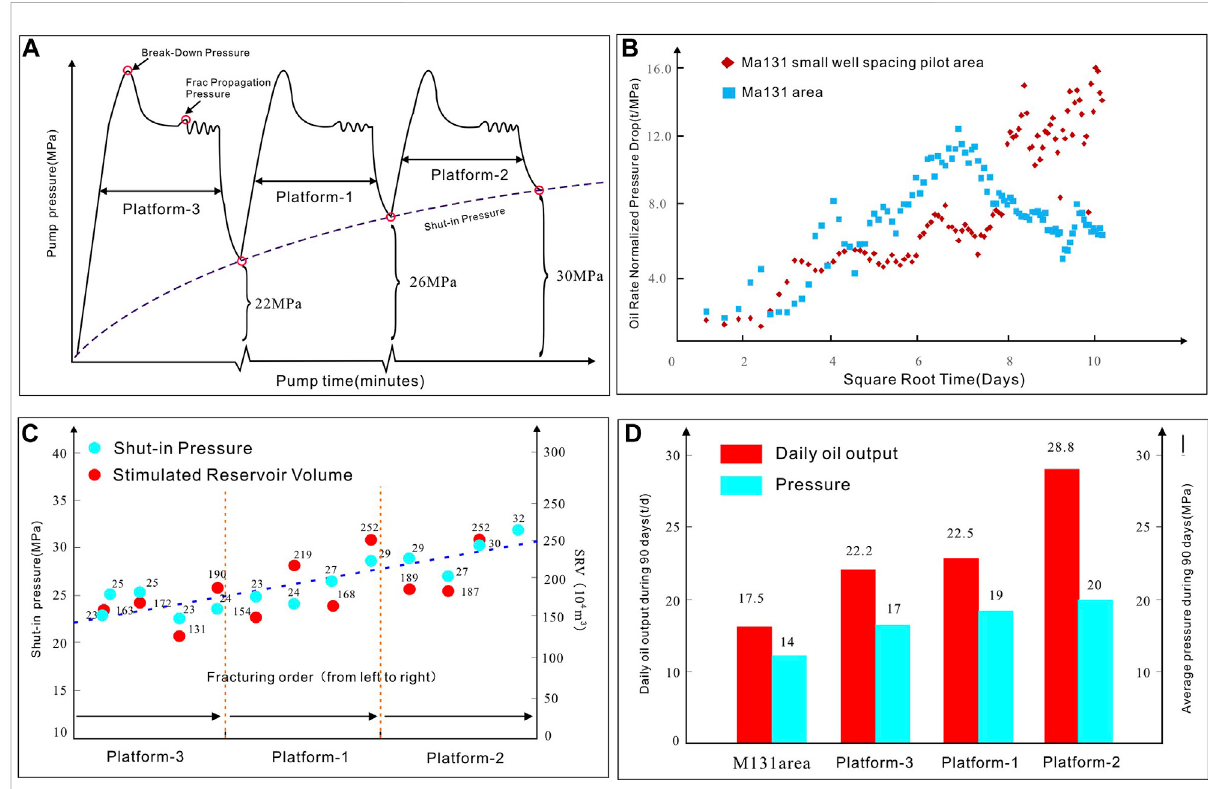
FIGURE 7 (A) Shut-in pressure of different platform plots; (B) reciprocal productivity index plot of the average of Ma131 small-well-spacing pilot wells compared to a typical well; (C) shut-in pressure and stimulated reservoir volume in Ma131 small-well-spacing pilot wells; (D) daily oil output of Ma131 small-well-spacing pilot wells compared to typical